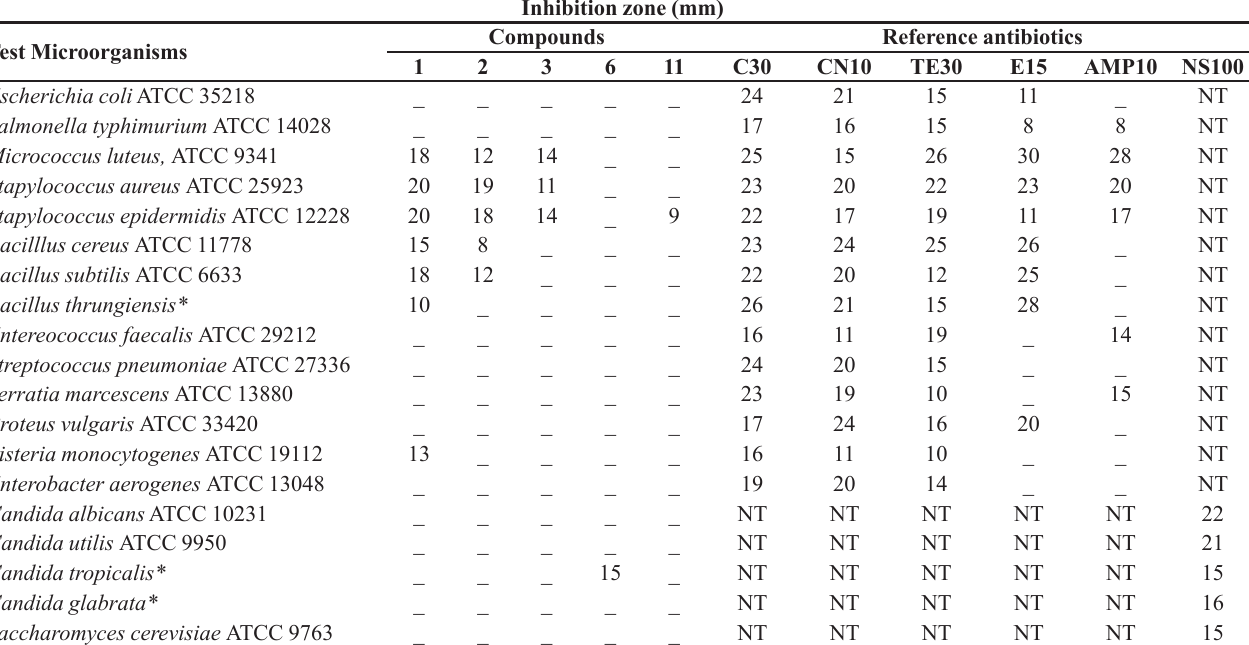
Inhibition zone (mm) Compounds Reference antibiotics